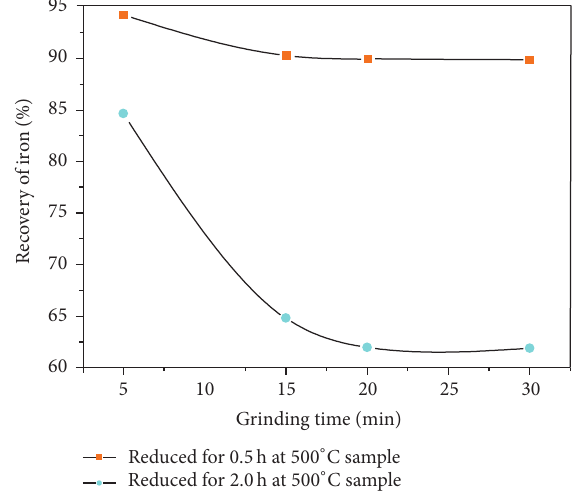
Figure 13: Effect of grinding time on the recovery of iron.